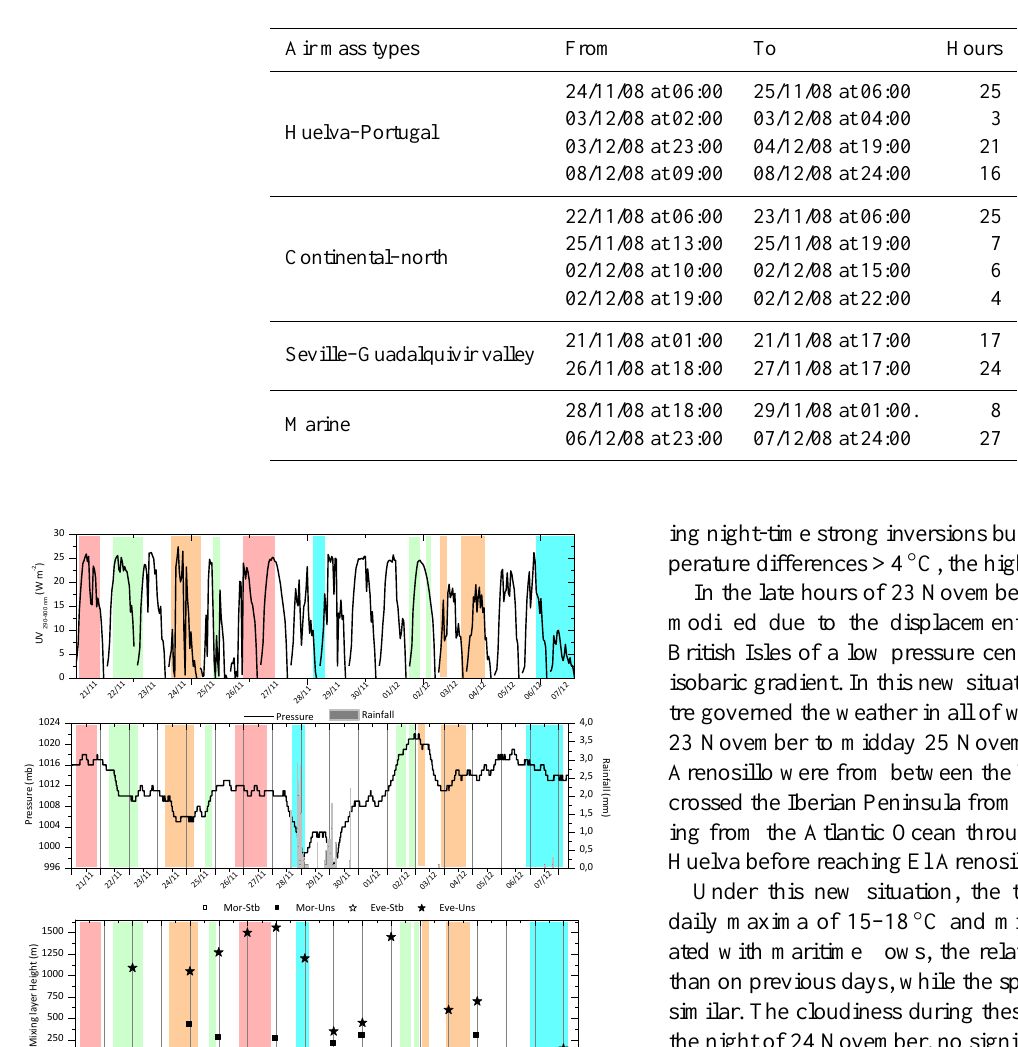
Table 3. Periods classified into distinct sectors of air mass origin.